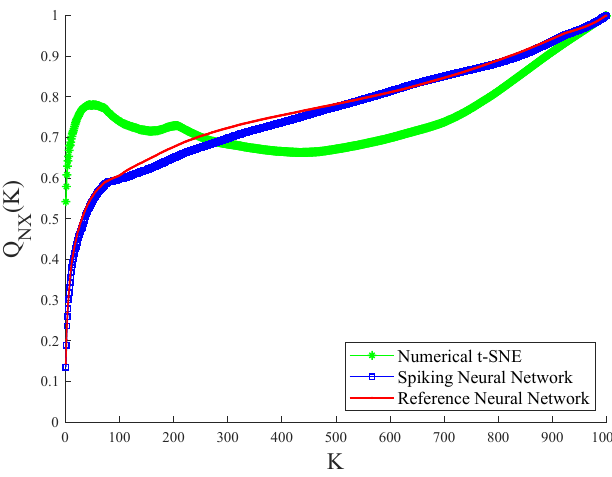
Figure 7. MSE values. ( a ) MSE-1: Spiking versus Reference. ( b ) MSE-2: Random versus Reference.